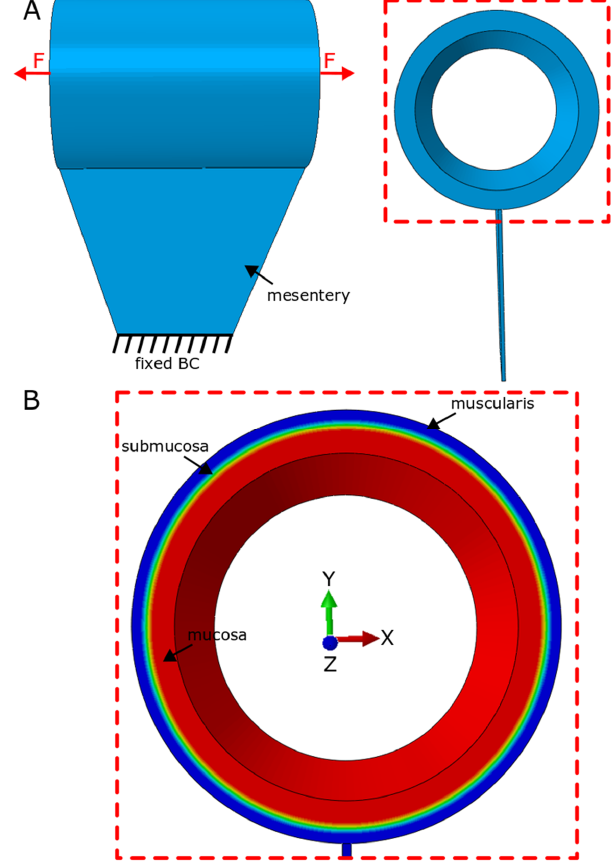
Figure 5. Finite element model for distraction enterogenesis. ( A , B ) Frontal and cross-sectional view of the model with mucosa, submucosa and muscularis layers shown in red, yellow/green and red, respectively, in the distracted segment. Model also includes mesentery layer attached to the distracted segment on the mesentery side. Fixed boundary conditions were used for bottom end of mesentery layer. BC and F in ( A ) are abbreviations for boundary condition and